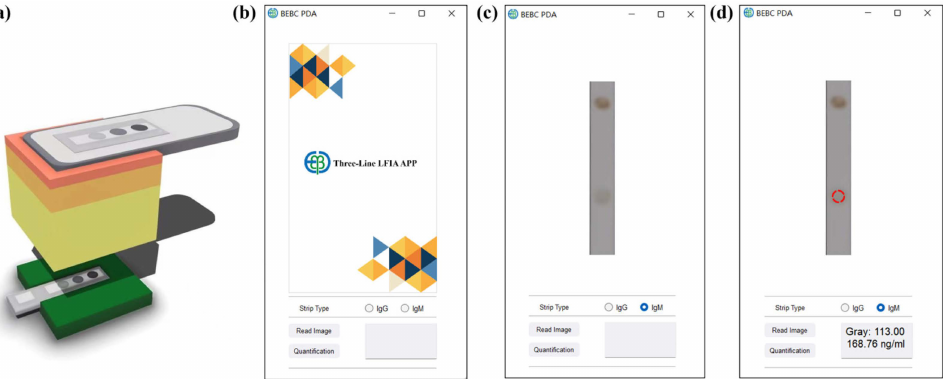
Figure 5. Software design for quantification of the three-line LFIA. ( a ) A Lego block-assembled smartphone reader for controlling illumination. ( b ) Main page of the designed software. ( c ) Select a page, including importing a photo and choosing the detected antibody type. ( d ) Result page shows the test line area extraction result (red dashed-line circle) and quantification result in the right